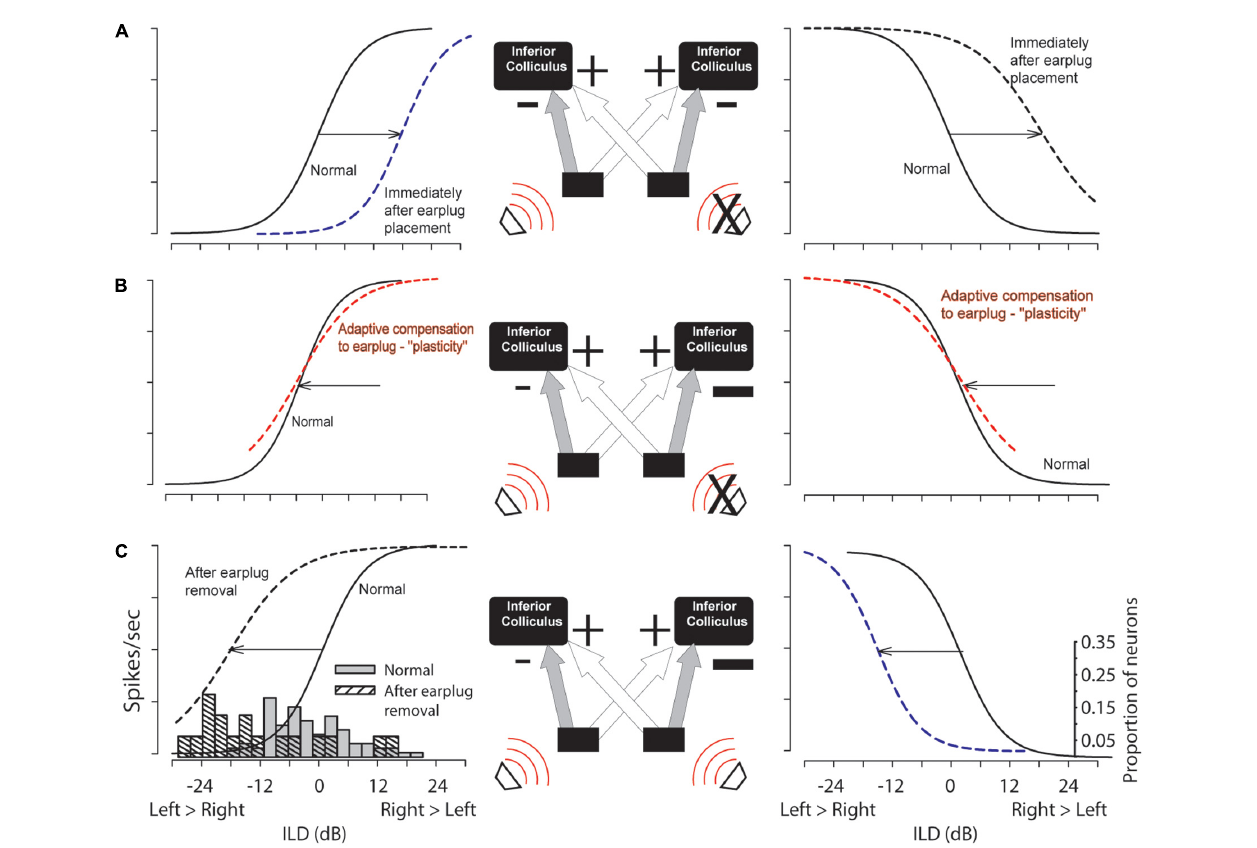
FIGURE 2 | Hypothesized changes due to CHL (right ear, “X”) in circuit function and the sensitivity to ILDs in the left (contralateral to earplug) and right (ipsilateral to earplug) ICC are shown in (A,B) with empirical data shown in (C) . The simplified circuit shows ipsilateral inhibitory (“–”) and contralateral excitatory (“+”) inputs to the ICC (strengths indicated by sizes of the symbols). (A) Relative to ILD coding in normal hearing controls (solid lines) ILD coding shifts to the right due to earplug insertion (dashed). (B) Hypothetical shifts in ILD coding if circuit plasticity has compensated for unilateral earplug over time. (C) Upon earplug removal, ILD coding shifts left due to the CHL-induced altered circuitry. Histograms: empirical half-max ILDs form ICC neurons in normal hearing controls ( n = 31) and experimental group after earplug removal ( n =